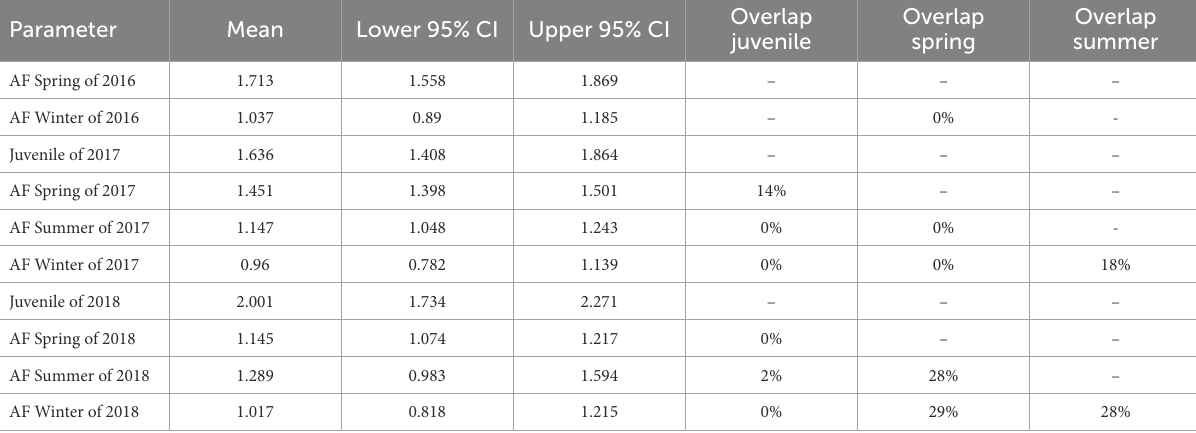
TABLE 1 Results from the ANOVA in a Bayesian hierarchical framework testing the effect of year and seasonal groups (i.e., Spring: March – May, Summer: June – August, Winter: November – February) on the percent of fecal nitrogen in the diets of desert bighorn sheep at Lone Mountain, Nevada (2016–2018).